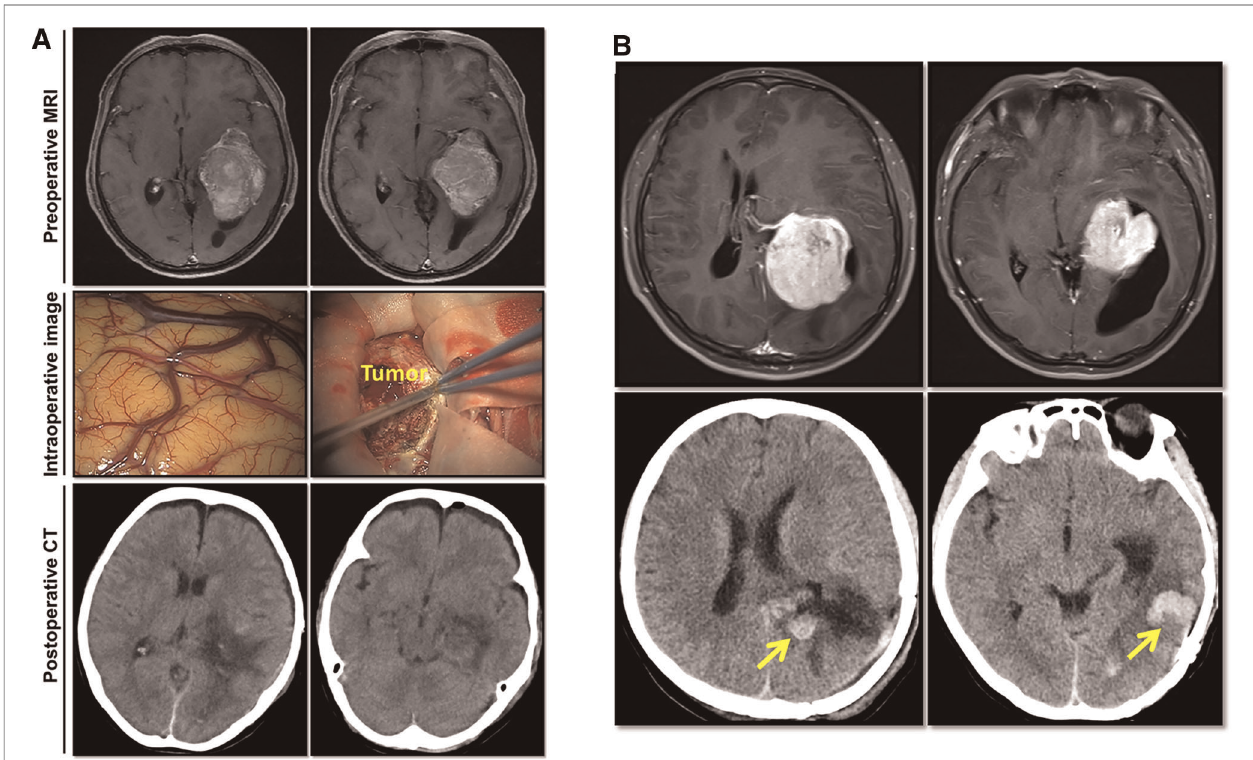
FIGURE 1 | Imaging studies of two representative lateral ventricular trigone meningioma (LVTM) patients. ( A ) A 63-year-old female patient presented with dizziness and headache. Preoperative axial enhanced T1-weighted magnetic resonance imaging (MRI) showed a huge mass in the left trigone area. Intraoperative observation and postoperative computed tomography (CT) imaging showed a total tumor resection. On a 6th postoperative day, she had a fever of 38.5°C with a headache and meningeal signs. The CSF test showed elevated white cell count (394 10 6 /L), protein level (>3,000 mg/L), and decreased glucose level (<1.1 mmol/L). Lumbar drainage was performed, and meropenem was used according to empirical therapy. Due to the negative CSF smear and culture results, meropenem was used continuously. On the 20th postoperative day, the patient had maintained a normal temperature for a week. CSF tests were repeated three times with normal results. The drainage was removed, and the meropenem was stopped. The patient was discharged from the hospital on the following day. ( B ) A 35-year-old male patient presented with a headache. Preoperative axial enhanced T1-weighted MRI revealed a large mass in the left trigone area (upper image). Postoperative 24-h CT showed total tumor resection with the tumor cavity hemorrhage (lower image). The patient showed mild headache without fever disturbance of consciousness. On a postoperative day 7, he had a continuous fever of 39°C. The CSF test showed elevated white cell count (754 10 6 /L), protein level (>3,000 mg/L), and decreased glucose level (<1.1 mmol/L). Lumbar drainage was placed, and meropenem was used according to empirical therapy. As the CSF culture showed methicillin-resistant Staphylococcus aureus , meropenem was replaced by vancomycin. On the 33rd postoperative day, the patient had maintained normal temperature for a week with 3 times of normal CSF tests. The drainage was removed, and vancomycin was stopped. The patient was discharged from the hospital on the following